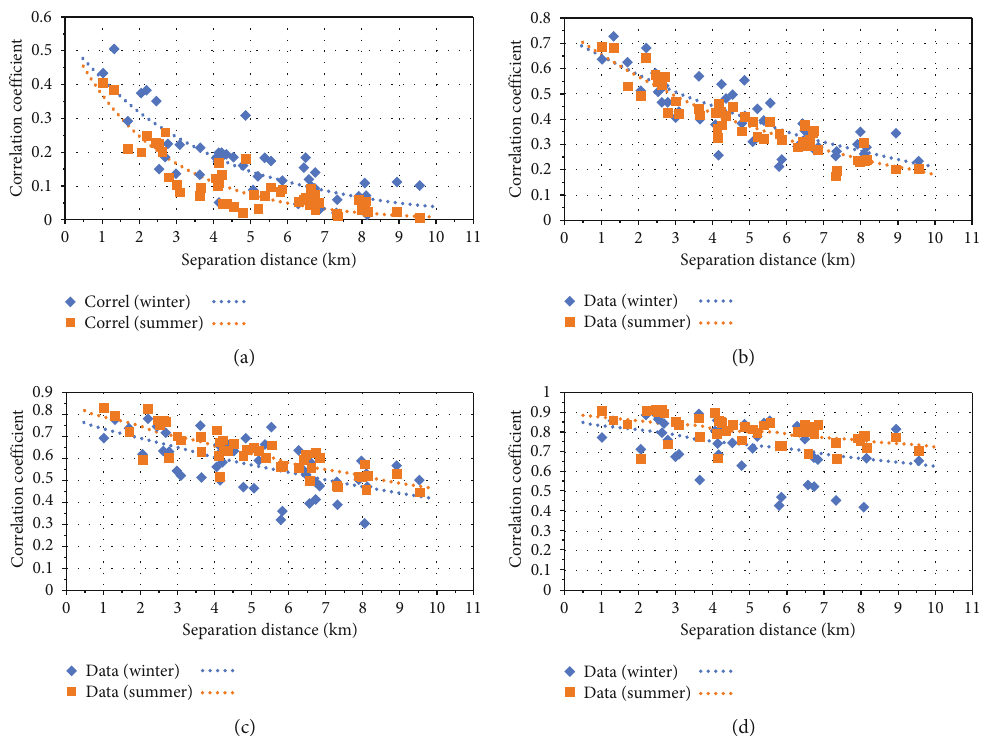
Figure 10: Variation in correlation coe ffi cient with distance in New York. Reproduced from Smith and Armstead [41]. Graph (a) is relevant to the discussion in this